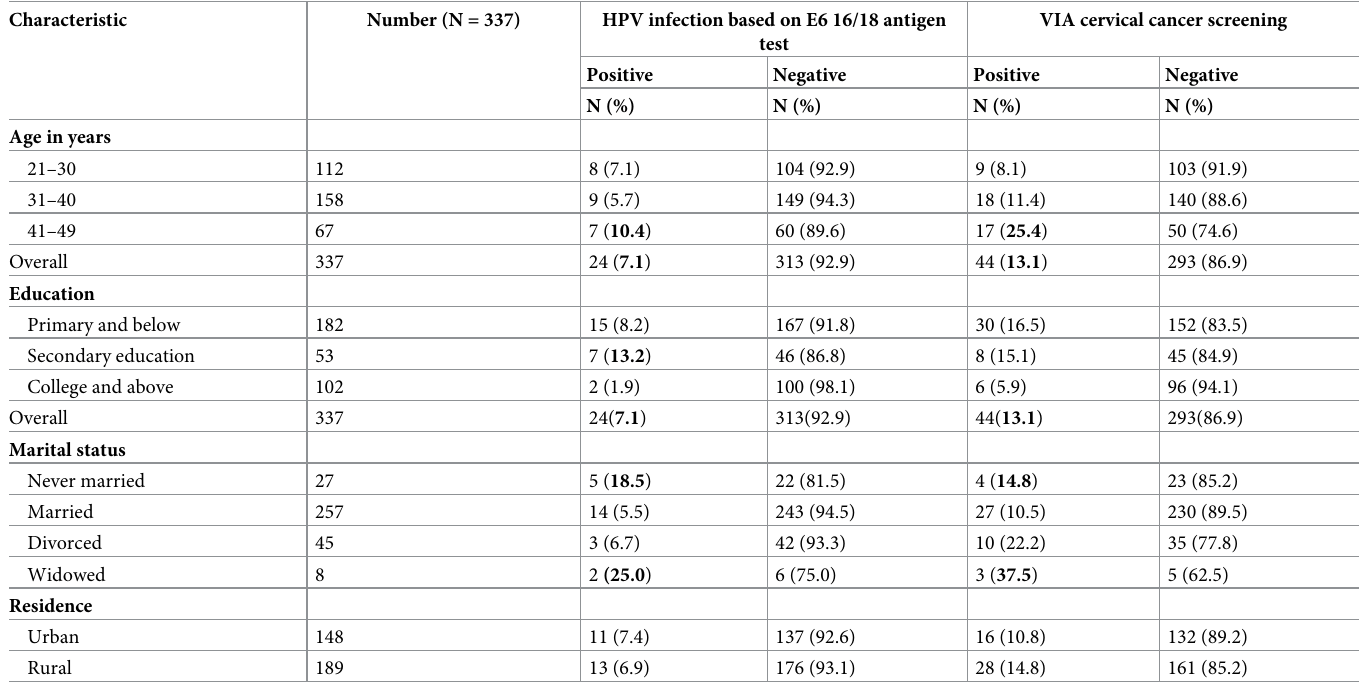
Table 3. Proportion of HPV infection and cervical lesions among participant women (n = 337) aged 21–49 years, Amhara region, Ethiopia, 2019.